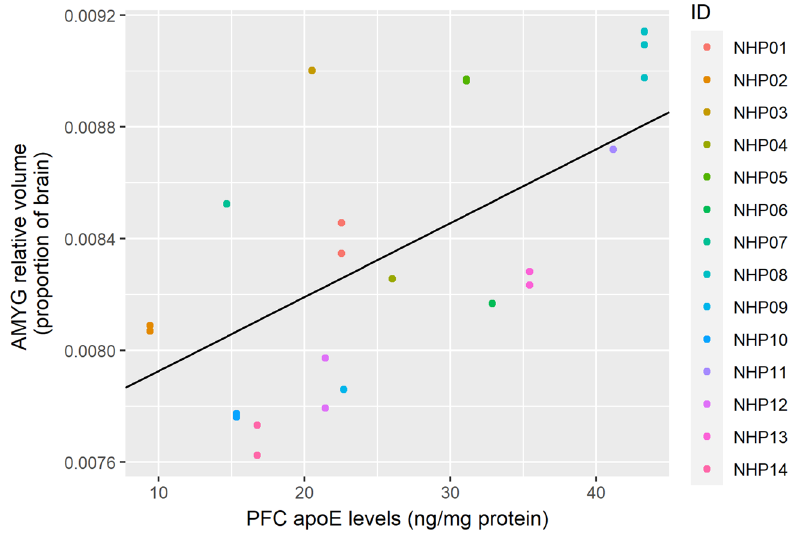
Figure 5. Levels of apoE in the PFC positively predicts relative AMYG volume. This is the opposite effect of the AMYG apoE on relative AMYG volume. The figure shows results from a GEE model using PFC apoE levels as the sole predictor. Individual macaque IDs are distinctly colored.